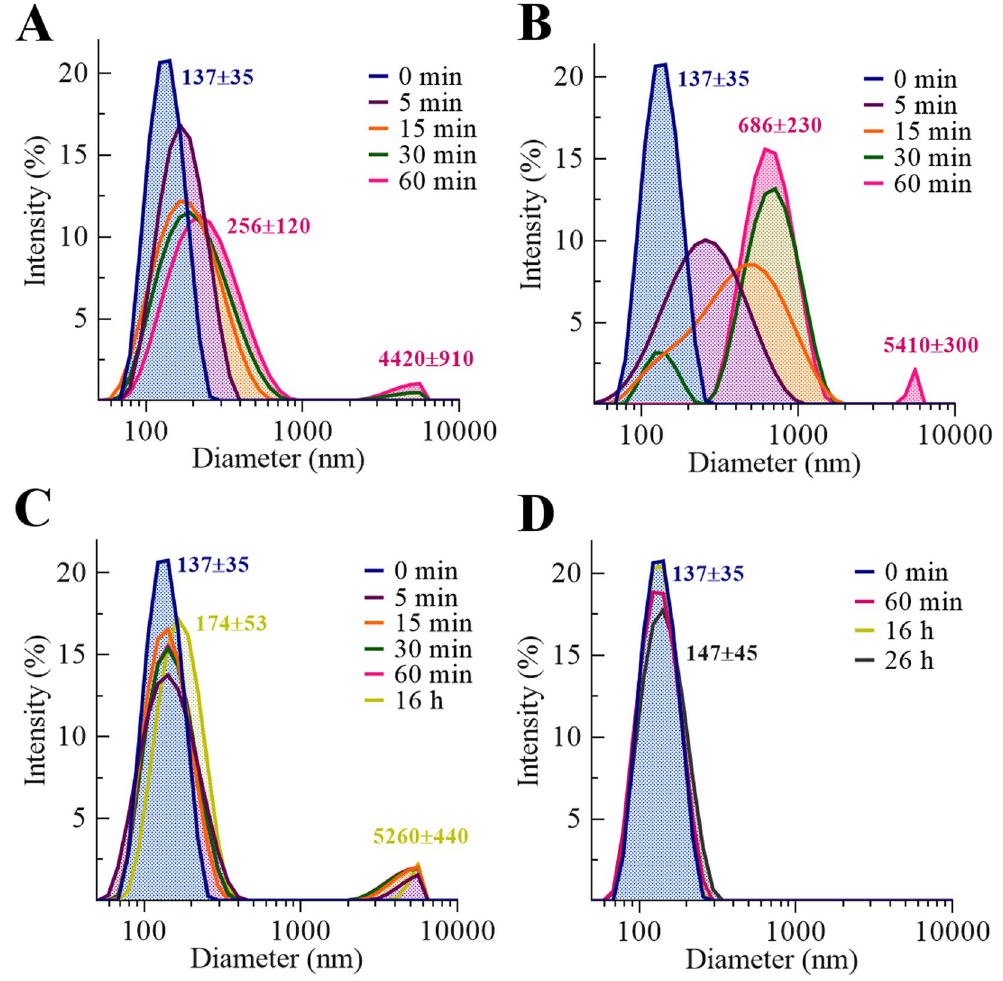
Figure 9. Vesicle size monitored by DLS. ( A , B ) PSI-treated vesicle size was monitored over time using 1:1 POPE:POPS LUVs (100 µ M phospholipid) incubated in 50 mM sodium acetate/140 mM NaCl buffer pH 4.5 with 10 µ M PSI under ( A ) non-reducing or ( B ) reducing (10 mM DTT) conditions. ( C , D ) H3-induced vesicle fusion was also assayed using ( C) 10 µ M H3 and ( D ) 10 µ M K83Q H3 in the same manner as in ( B